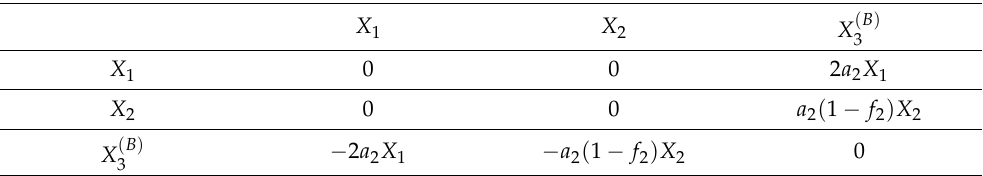
Table 3. Commutator table in the case